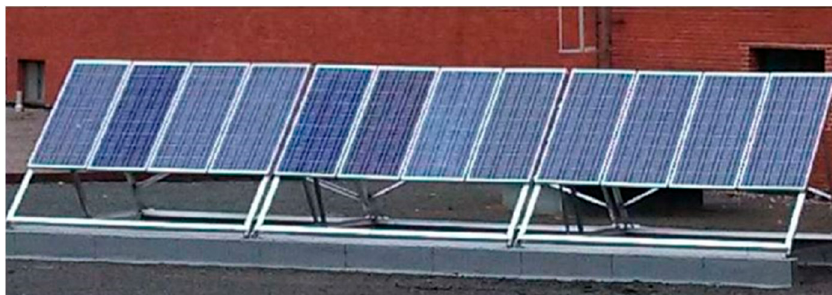
Figure 11. Rooftop solar panel.